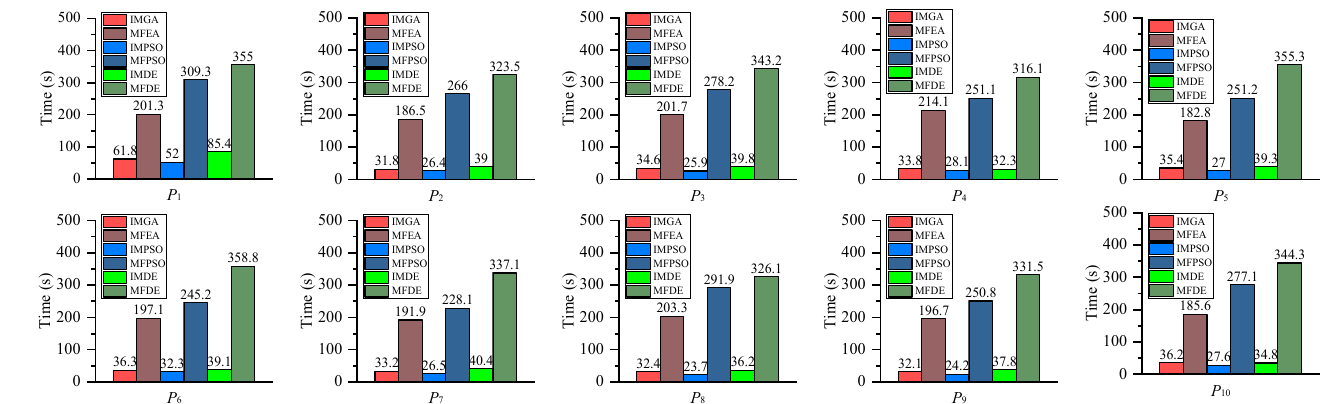
Figure 3. Comparison of six algorithms in terms of the average computational time (s) via 20 runs in test suite 2.